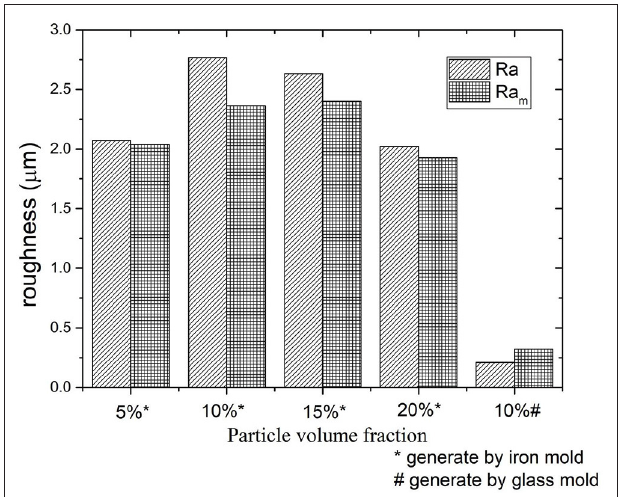
FIGURE 6 | Comparisons of roughness of MREs for different particle volume fractions with/without magnetic field.